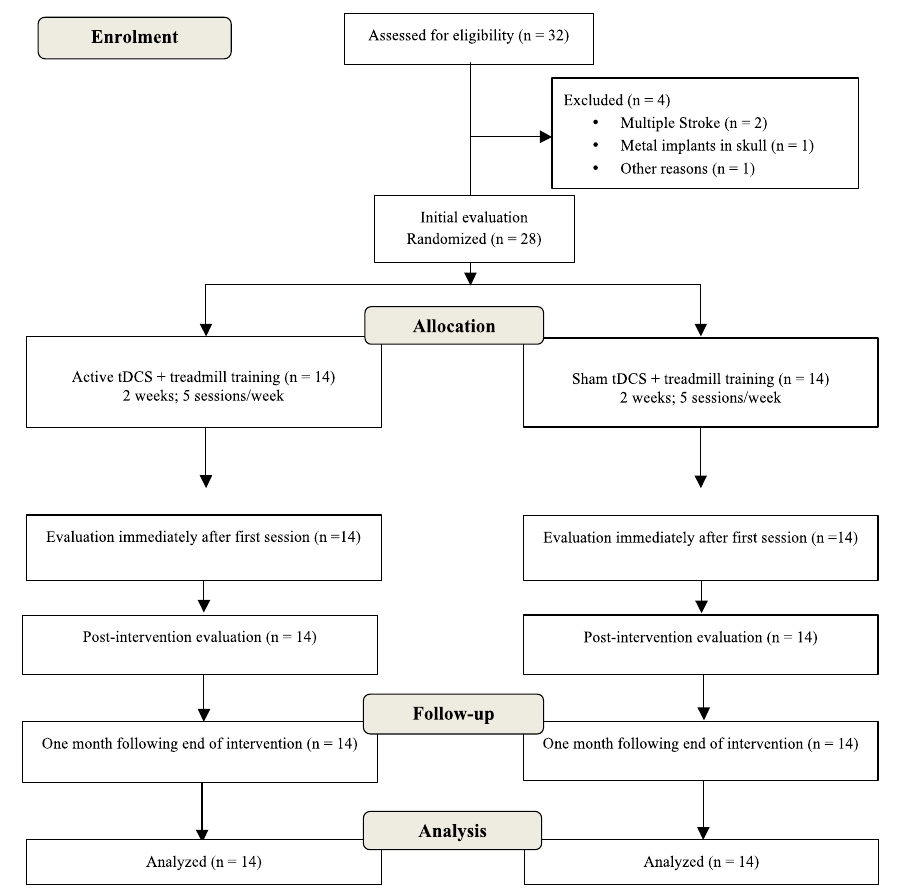
Figure 1. Flowchart of study based on Consolidated Standards of Reporting Trials (CONSORT). The results of the spatiotemporal gait variables in the two groups are summarized in Table 2. No significant improvements ( p > 0.05) in these variables were found among the evaluations in either